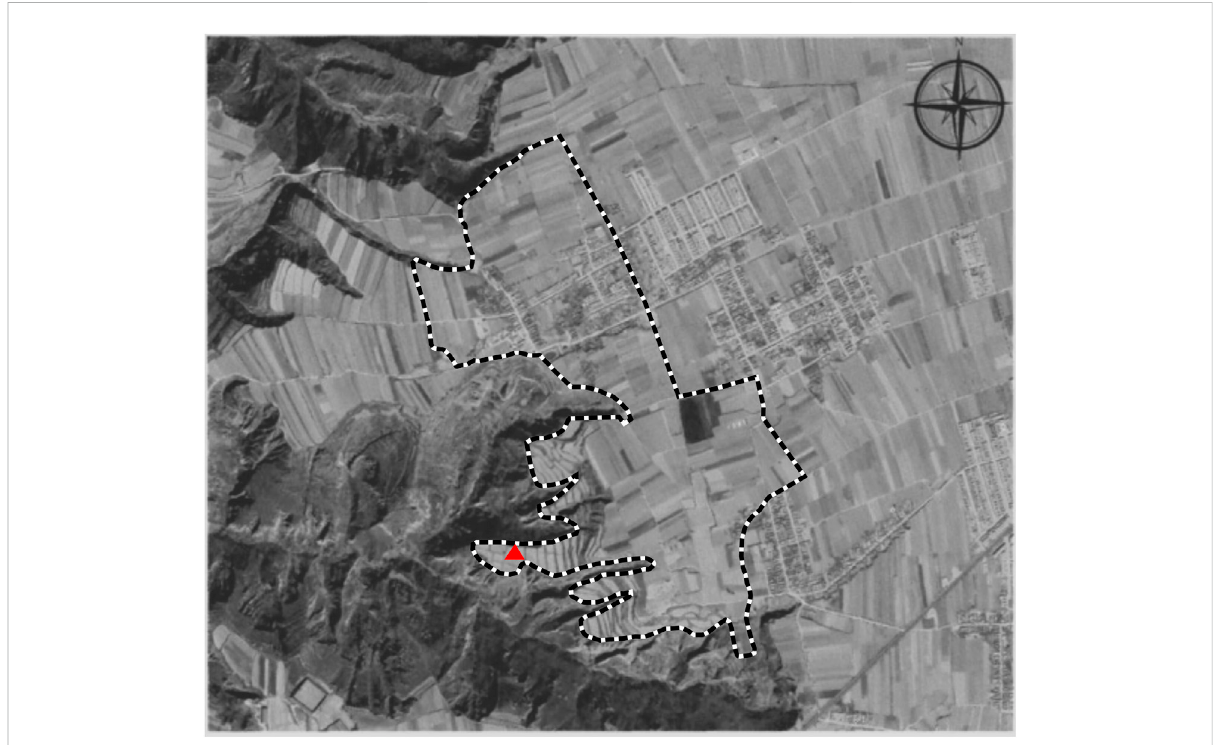
FIGURE 3 Thearea ofXitou. Theredtriangleindicates theYuzuipo locale,from which ourfaunalevidence hasbeenexcavated. Adapted fromXibeiDaxue Wenhua Yichan xueyuan et al.